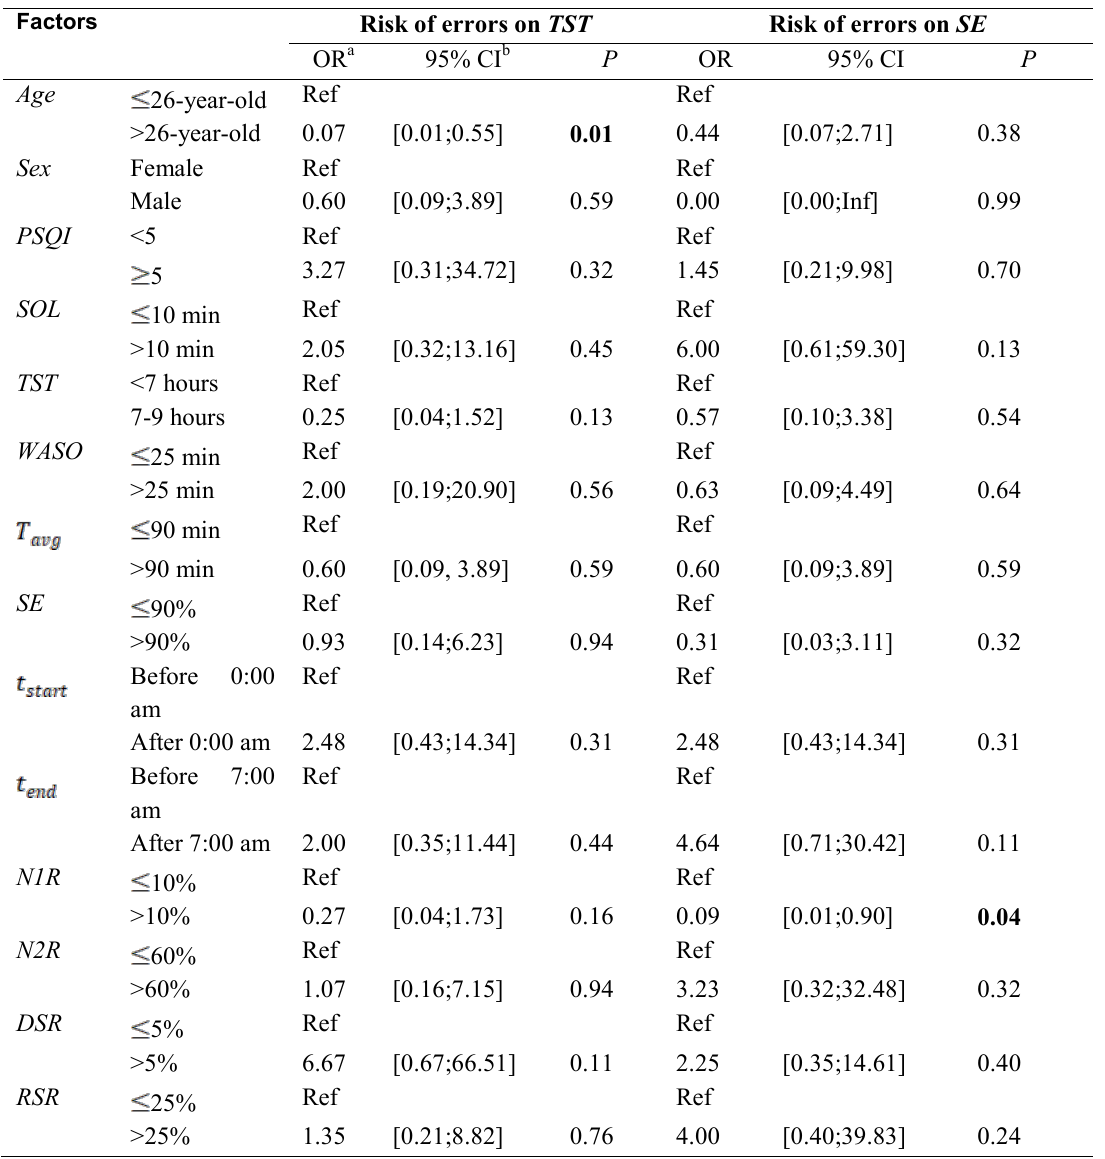
Table 6. Associations between factors and risks of measurement errors (Neuroon) Factors Risk of errors on TST Risk of errors on